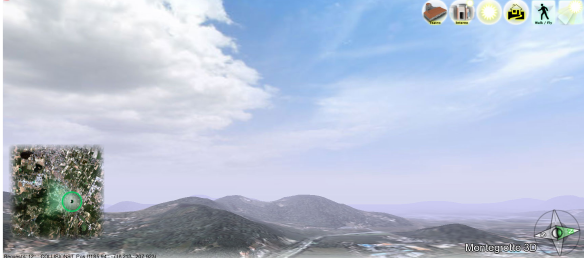
Figure 3. OSG4Web: new overlay 3D interface (icons, minimap, compass, info-area) on Montegrotto